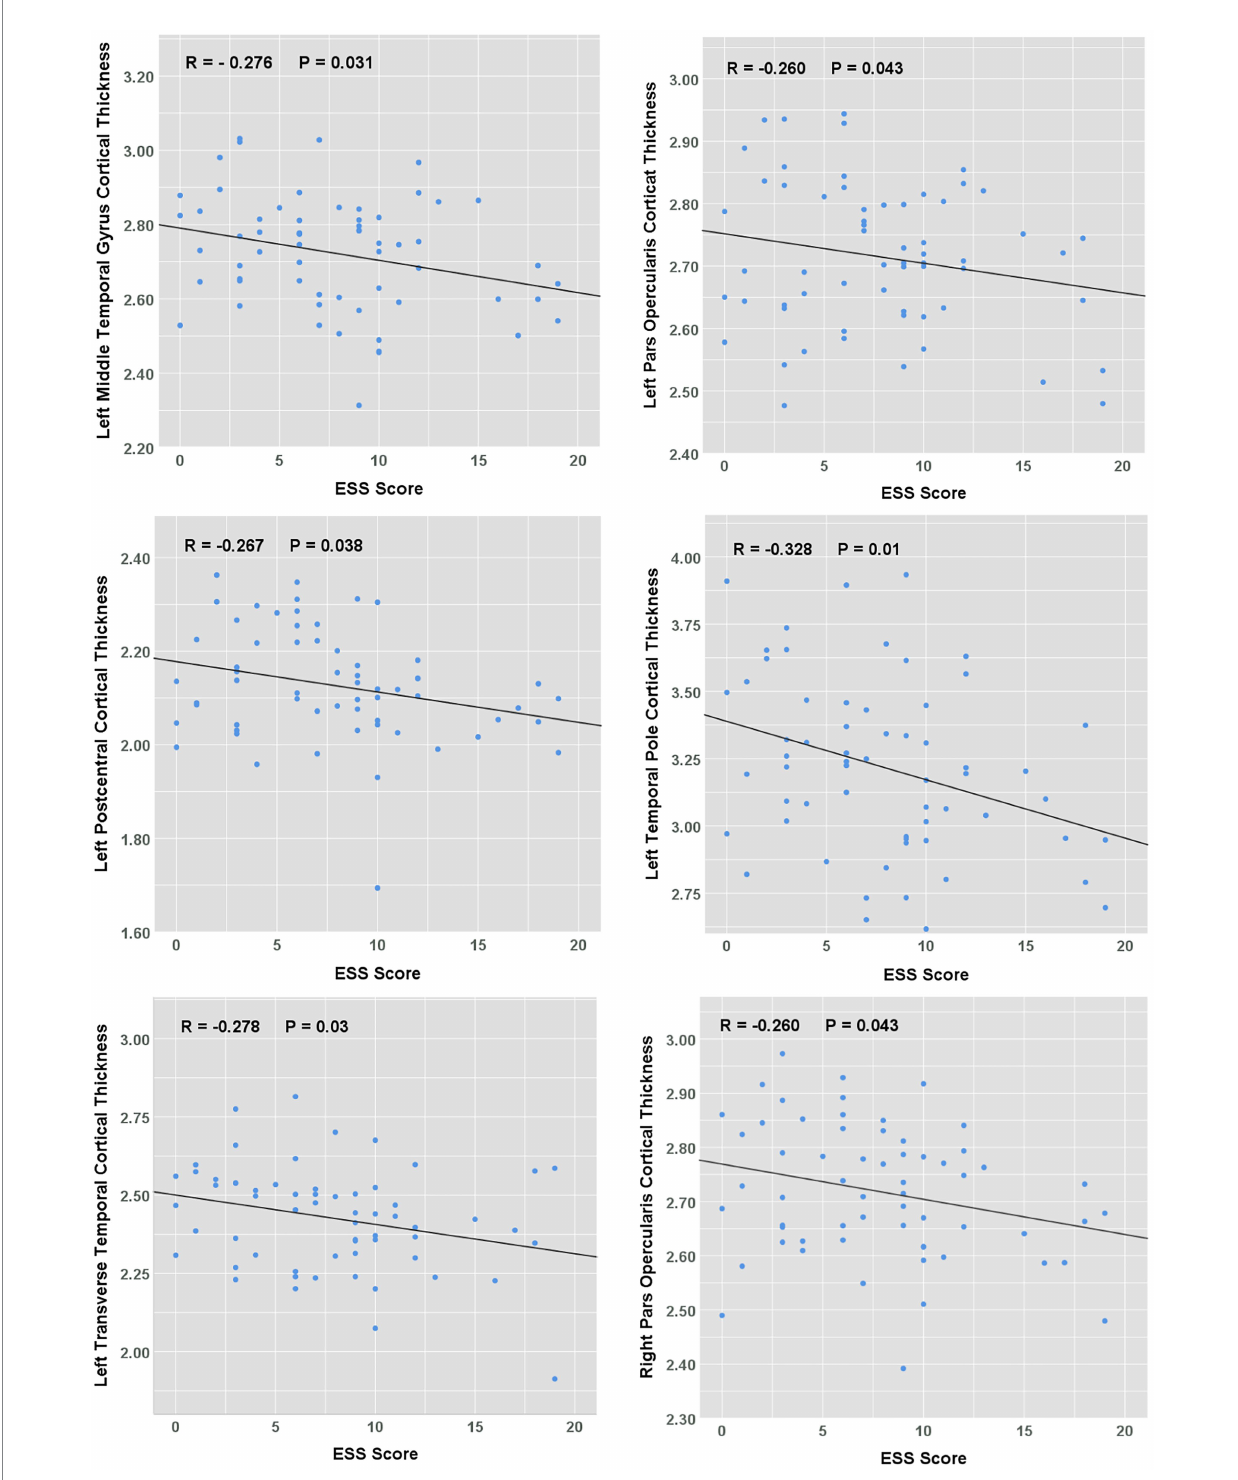
FIGURE 2 Correlation between ESS scores and cortical thickness in OSA patients. The scatterplots showing the relationship between ESS score and average cortical